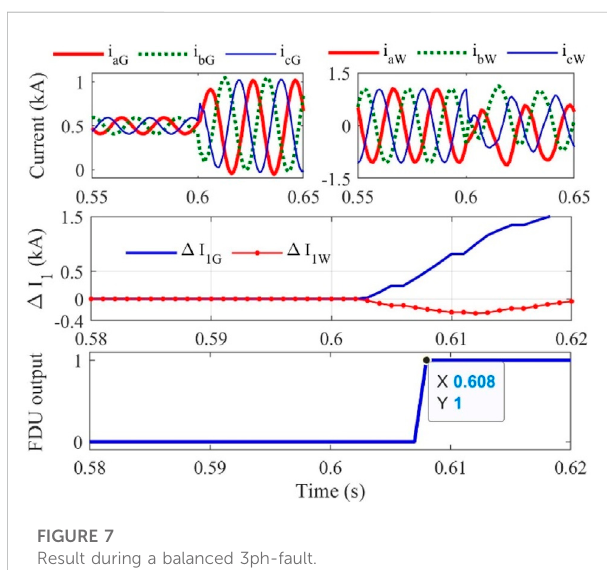
FIGURE 7 Result during a balanced